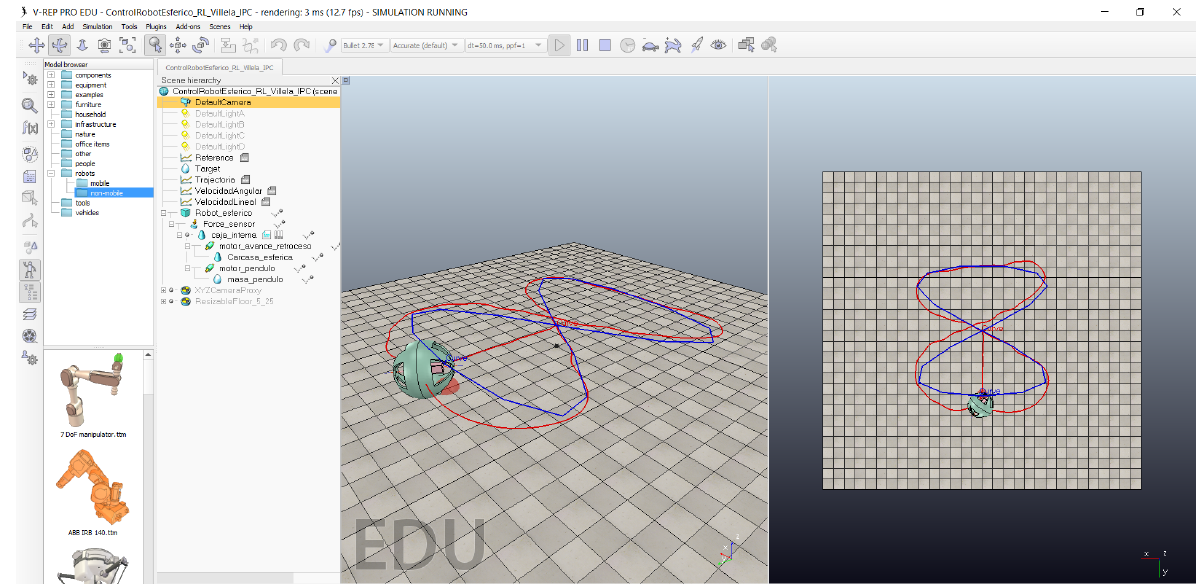
Figure 13. Path following of a Lissajous figure.